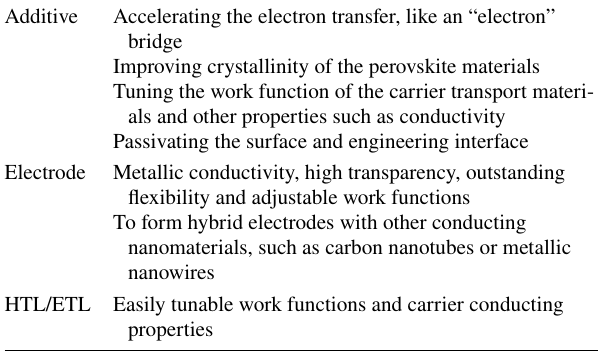
Table 1 Summary of the functions/properties of MXenes in different roles played in solar cells Additive Accelerating the electron transfer, like an “electron” bridge Improving crystallinity of the perovskite materials Tuning the work function of the carrier transport materi- als and other properties such as conductivity Passivating the surface and engineering interface Electrode Metallic conductivity, high transparency, outstanding flexibility and adjustable work functions To form hybrid electrodes with other conducting nanomaterials, such as carbon nanotubes or metallic nanowires